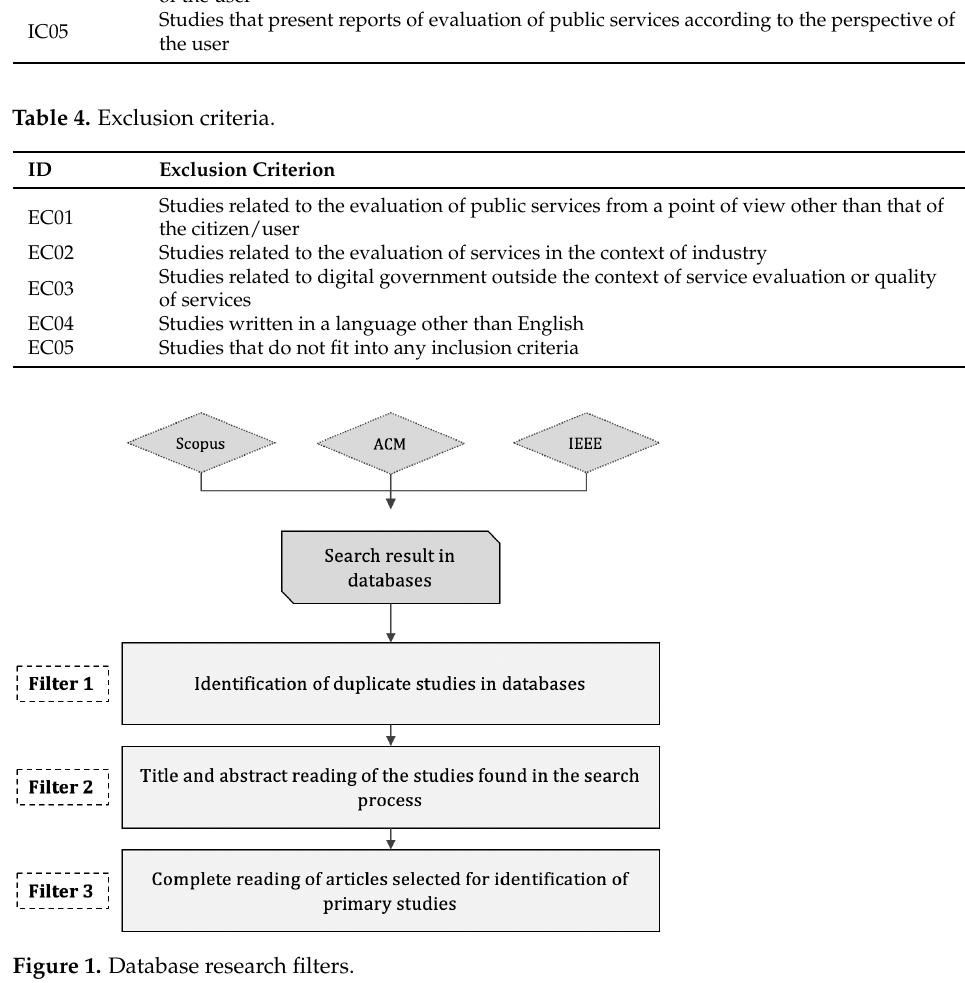
Figure 1. Database research